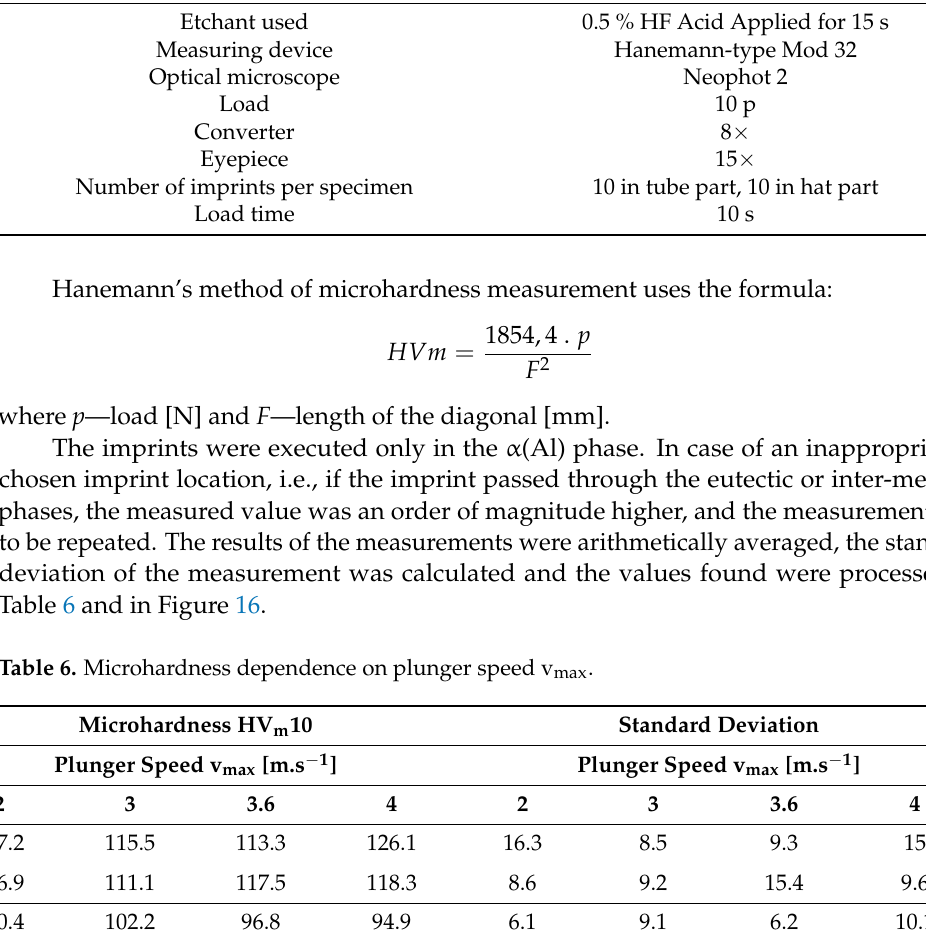
Table 5. Microhardness measurement parameters.